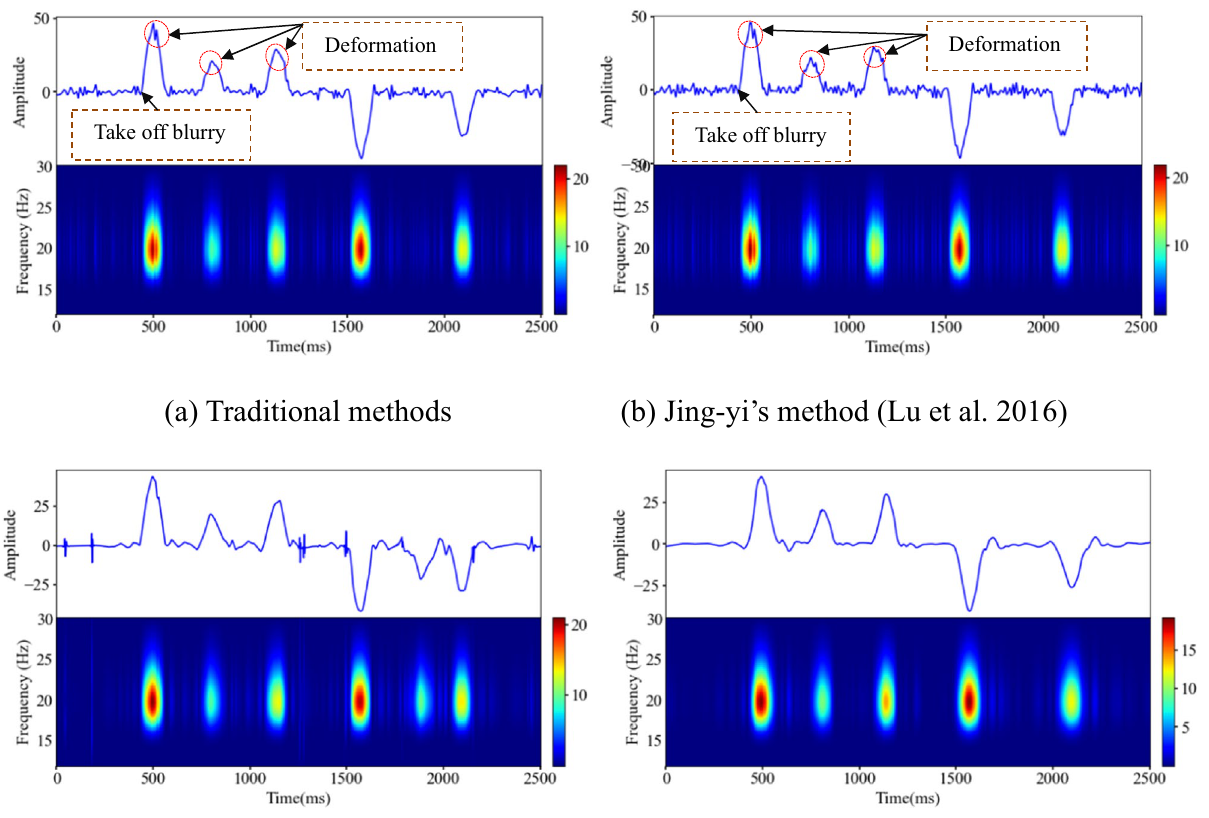
Figure 11. Results of denoising polluted signals using different wavelet threshold methods (Spyder(Python3.6)) ( a ) Traditional methods ( b ) Jing-yi’s method 24 ( c ) Huai-liang’s method 9 ( d ) The method proposed in this